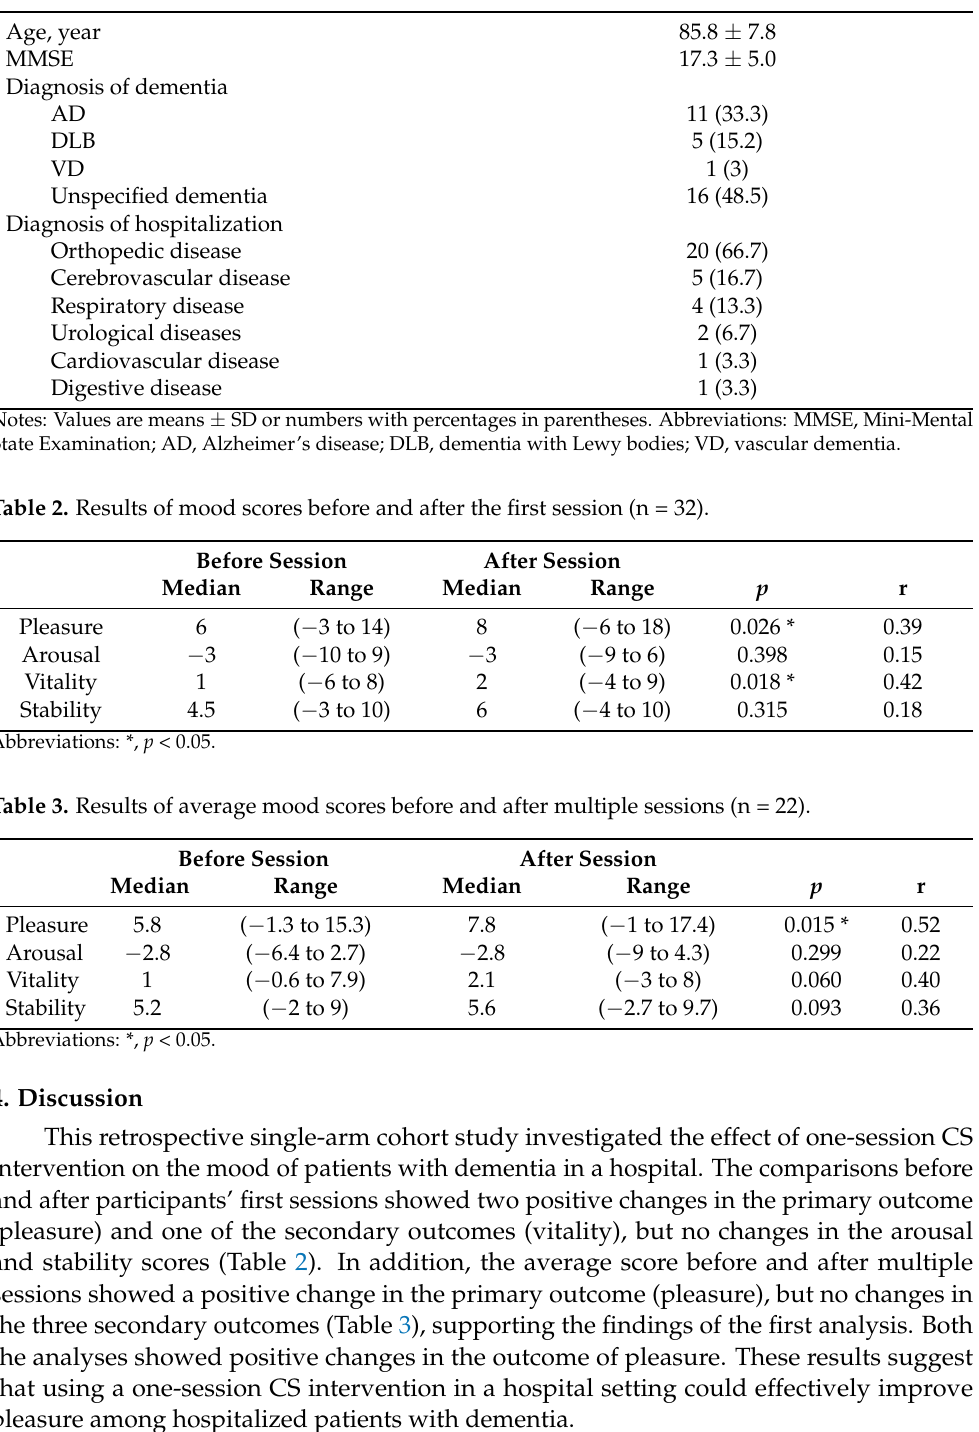
Table 1. Demographics of the study participants (n = 33).